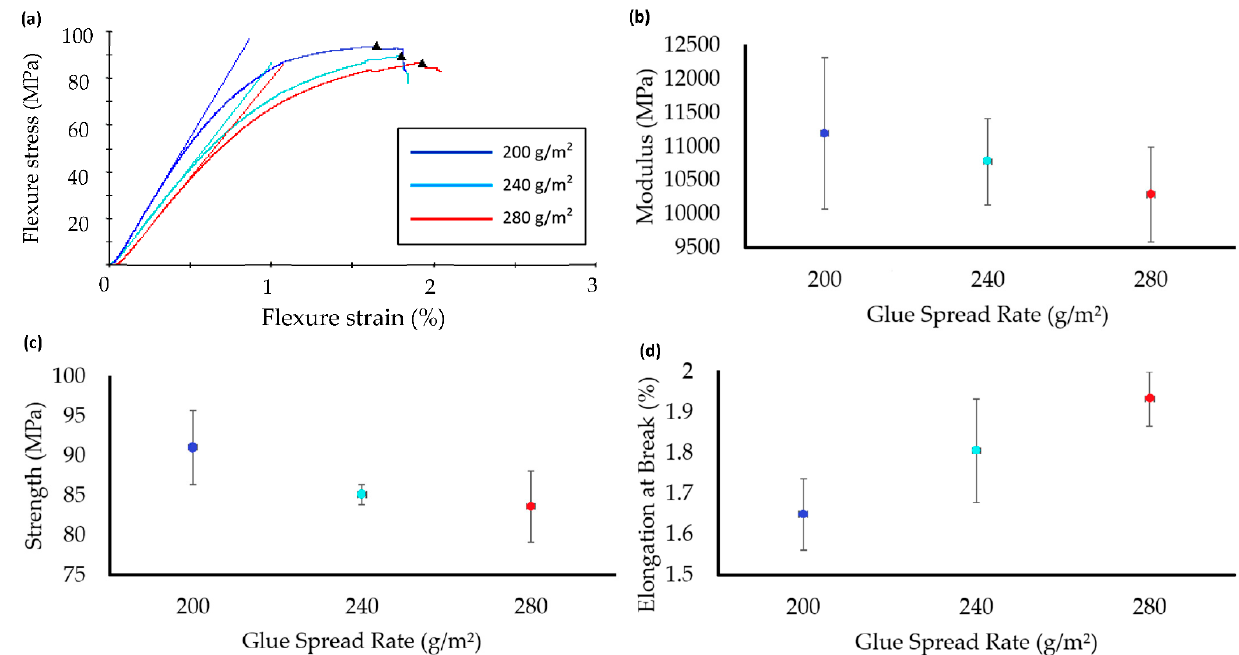
Figure 5. Mechanical characterization of LVL samples made with different glue spread rates by flatwise direction bending tests: ( a ) representative stress-strain curves for each treatment; ( b ) elastic modulus; ( c ) strength; ( d ) elongation at break.